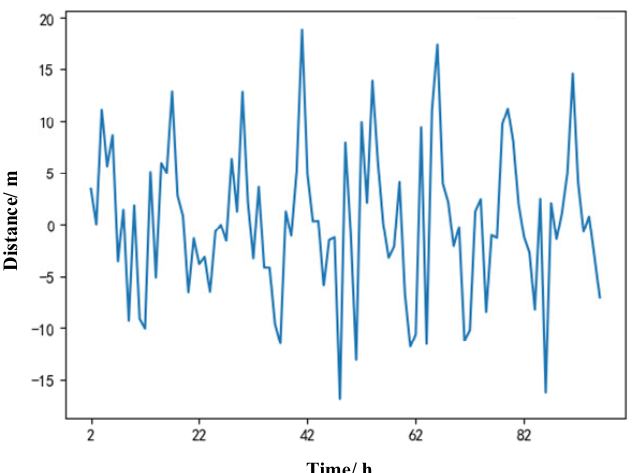
Figure 9. The first-order difference of offset distance.